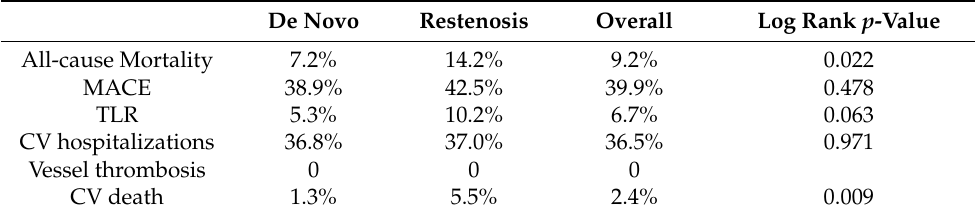
Table 3. Two-year clinical